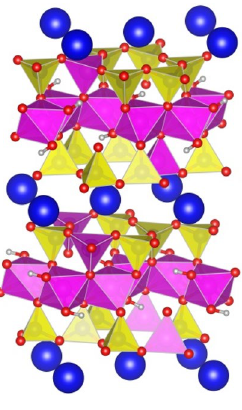
Figure 1. The structure of optimized bulk mica. Colored atoms are shown as: H (grey), O (red), K (blue), Al (pink) and Si (yellow). The coordination polyhedra around the Al atoms (pink polyhedra) and Si atoms (yellow polyhedra) are shown as